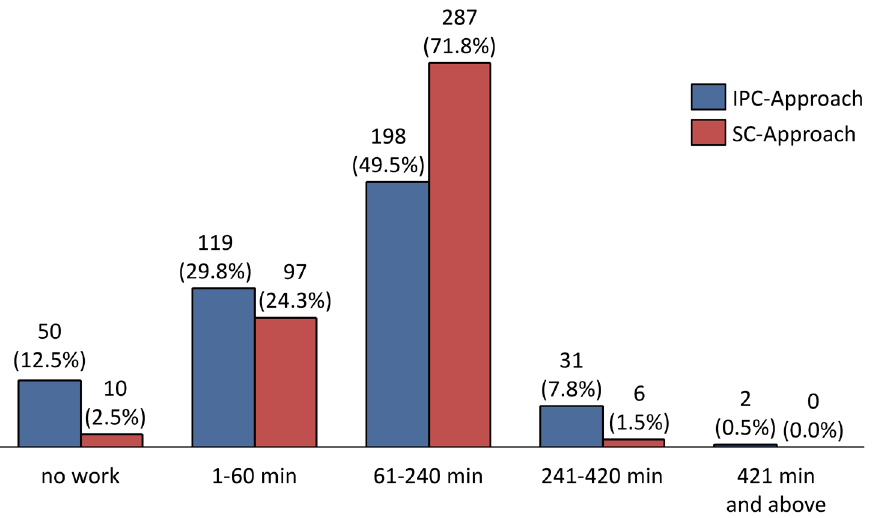
Figure 16: Overview of days with specific accumulated work durations for IPC (blue bars) and SC (red bars) approach. Values above bars are actual day counts for each category and the percentage of the total